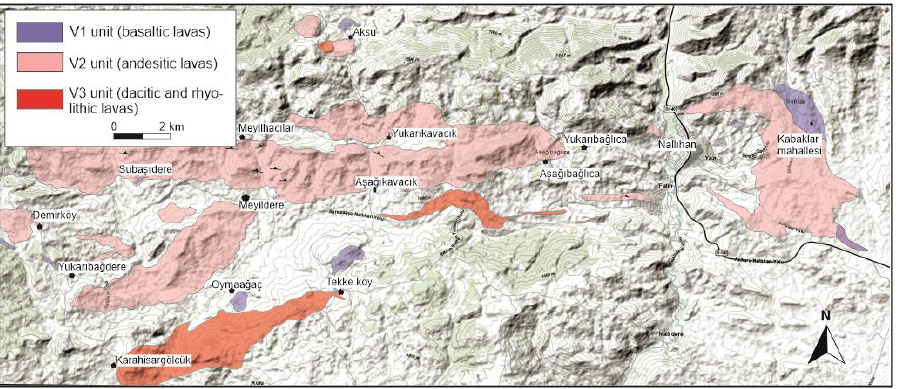
Figure 2. Simplified sketch map showing the distribution of the basaltic (V1 unit), andesitic (V2 unit), and dacitic – rhyolitic lavas (V3 unit) in the Sarıcakaya–Nallıhan Basin.